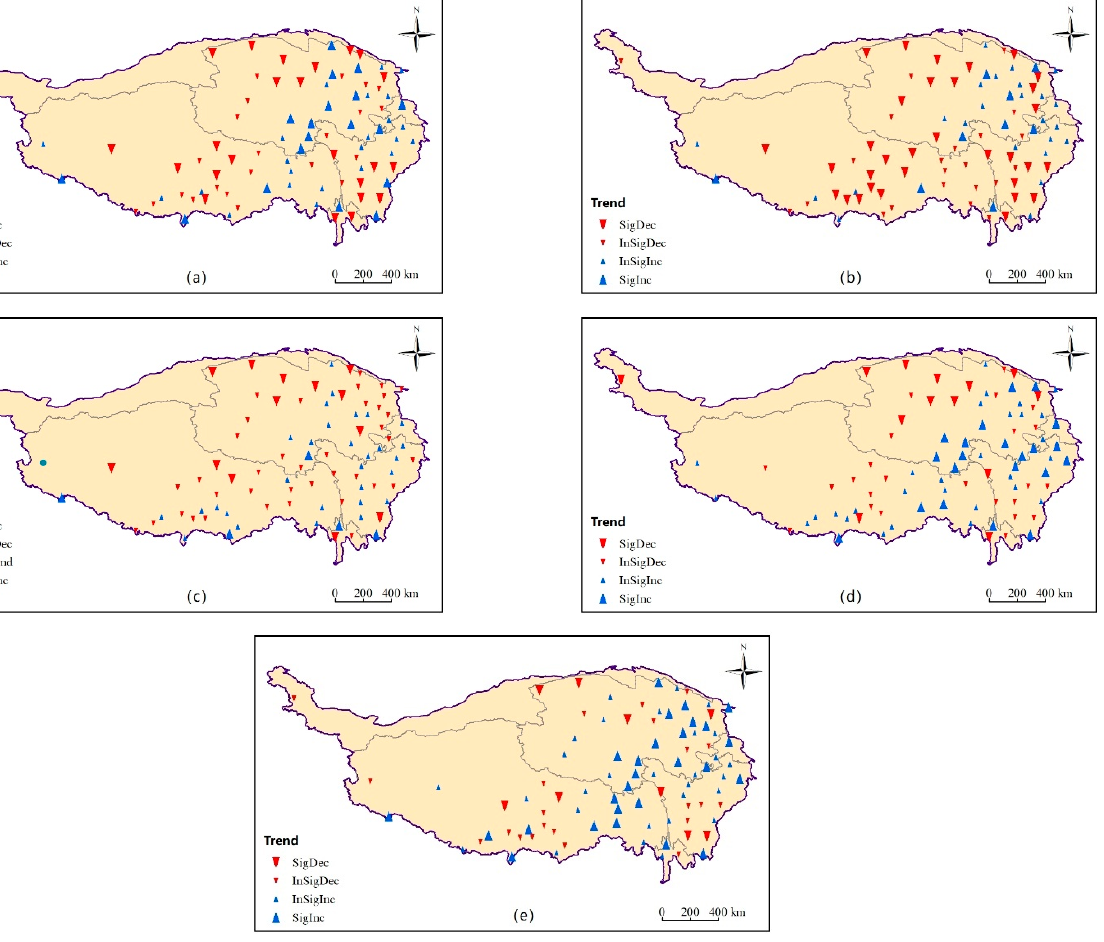
Figure 7. Annual and seasonal spatial trends of Epan on the TP in 1966–2016. ( a ) Annual, ( b ) spring, ( c ) summer, ( d ) autumn, ( e ) winter.